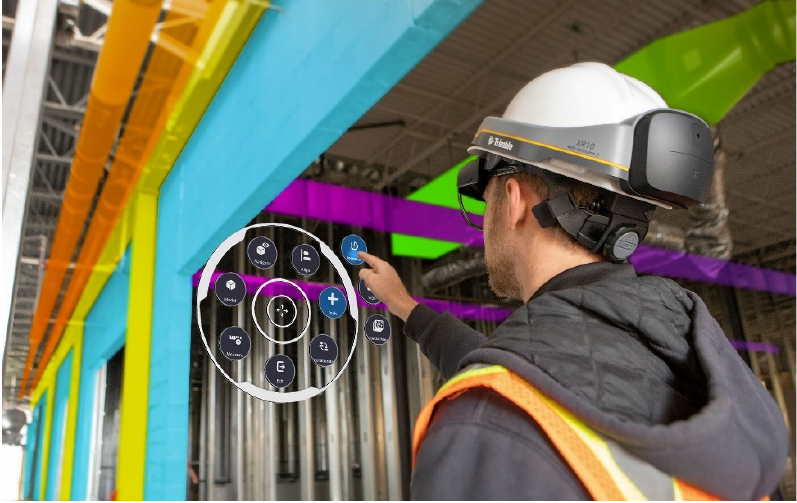
Figure 9. Example of Trimble XR10 MR application on construction site.